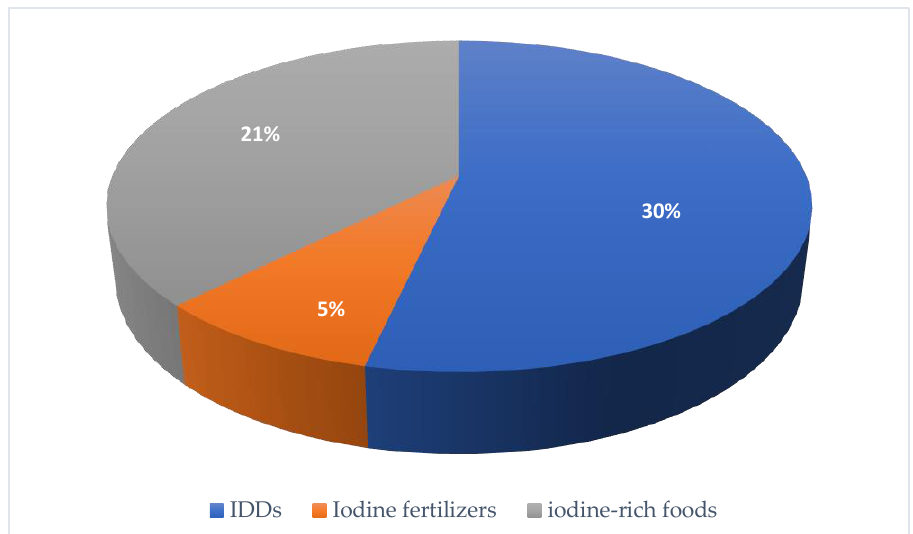
Figure 4. Percentage of farmers with knowledge on iodine deficiency, fertilizers, and sources. Farmers’ knowledge, perceptions, and intended adoption of iodine agronomic biofortification. Table 3. Descriptive statistics of constructs and